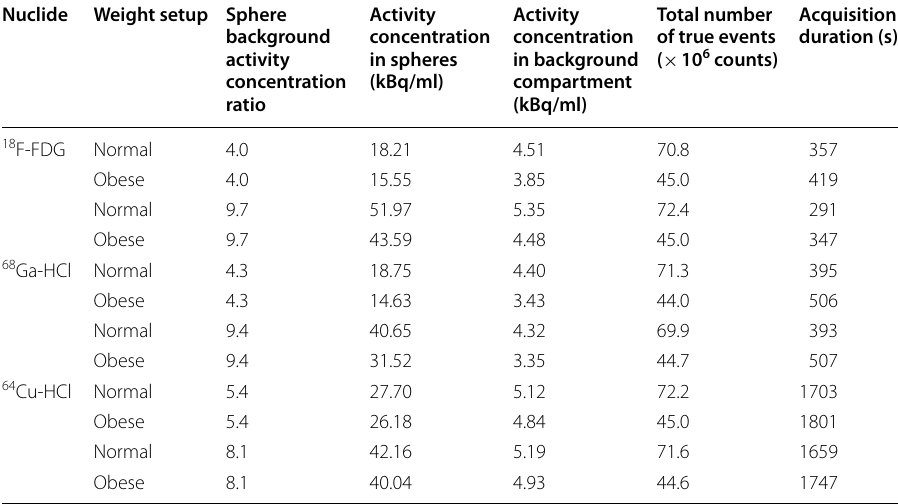
Activity concentration at the beginning of the acquisition and total number of detected true events throughout the duration of PET imaging